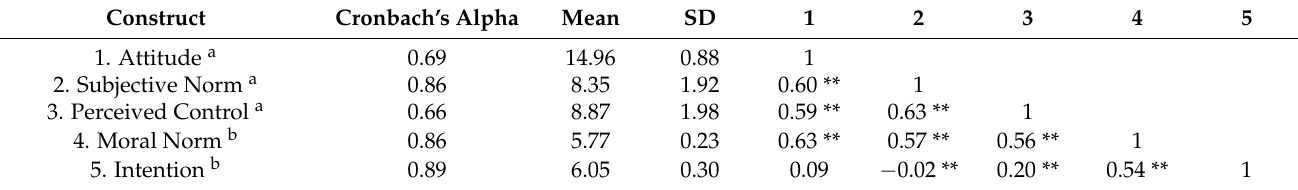
Table 2. Cronbach’s alpha, means, standard deviations, and correlations between latent constructs. Construct Cronbach’s